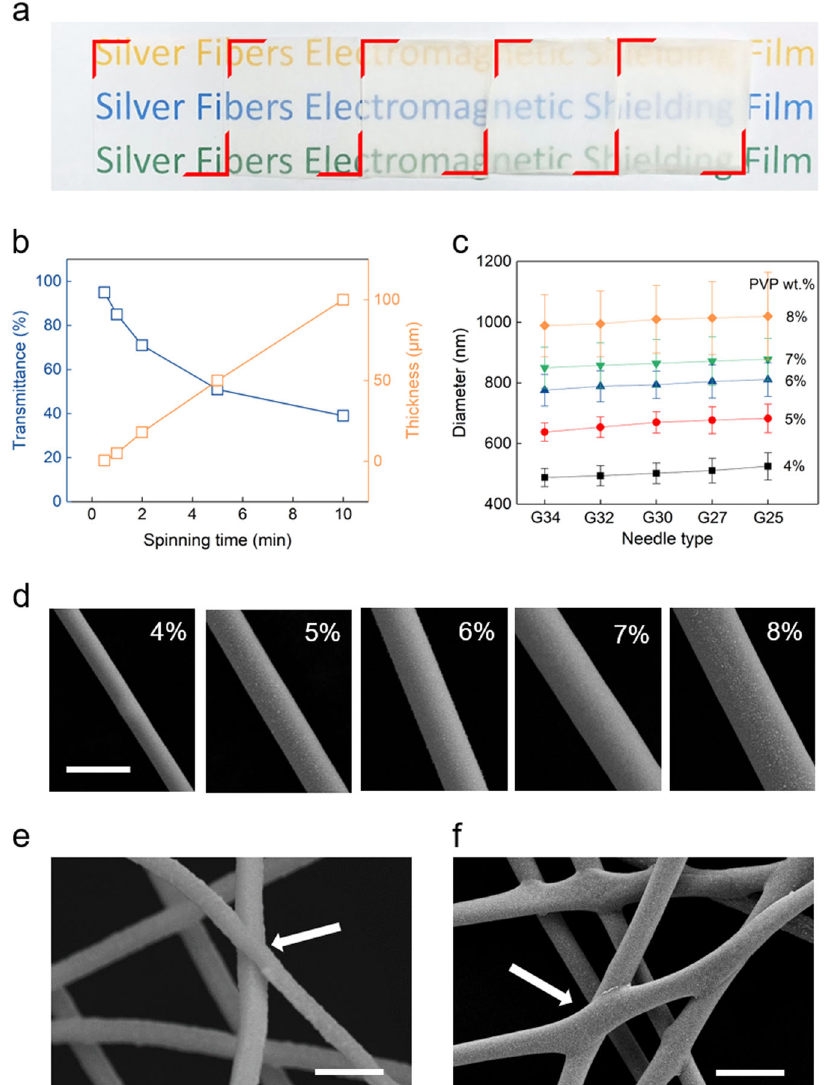
Fig. 2 Optical, crystallographic, mechanical and micromorphological characteristic of AgNF. a A photograph of as-prepared fi ber fi lm after different spinning times (from left: 1, 2, 5, 10, and 20 min). b Correlation of technological parameter include transmittance and fi ber thickness versus spinning time of blow-spinning. c Diameter of AgNF versus needle type. Corresponding inner diameter: 0.06 mm (G34), 0.11 mm (G32), 0.16 mm (G30), 0.21 mm (G27), and 0.26 mm (G25). d SEM of AgNF with different PVP concentration spun with G30 needle. Scale bar: 1 μ m. e , f SEM images of AgNF and junction interconnected AgNF. Scale bar: 1 μ